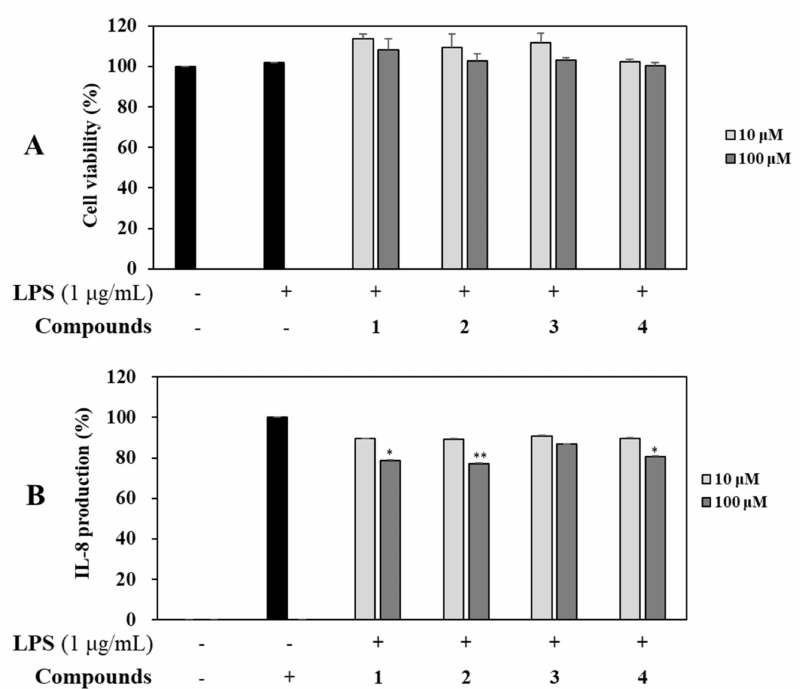
Figure 8. Effects of isolates 1 – 4 on the LPS-induced expression of IL-8 in HT-29 cells. HT-29 cells were treated with nagilactone B (10 and 100 µ M) for 2 h and stimulated with 100 ng/mL LPS for 18 h. The viability of cells was then determined using an MTT assay ( A ) and the level of IL-8 in the culture media was measured with an ELISA kit ( B ). The values are expressed as mean ± standard deviation of three individual experiments. Compared with the control group; * p < 0.05, ** p < 0.01 vs. LPS-treated